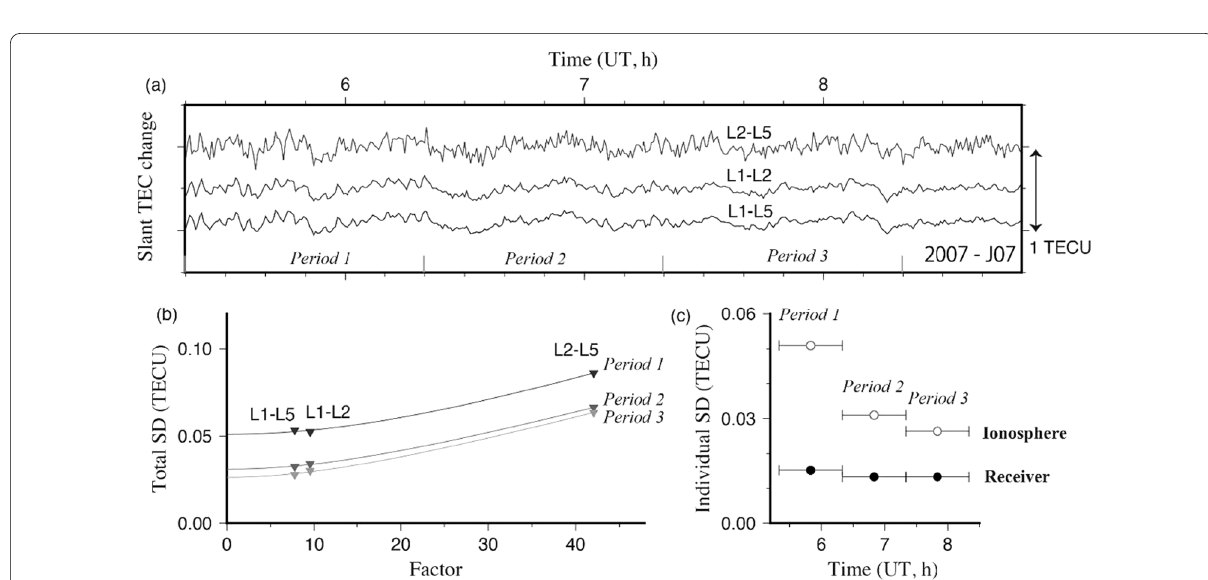
Fig. 7 a High-pass filtered slant TEC time series5:20–8:50 at the 2007 station observed using J07 satellite calculated with three different combinations of L1, L2, and L5 carrier phases. b Standard deviations of slant TEC σ tot obtained by the three combinations as a function of the frequency factor F in Eq. (1). Three curves correspond to Period 1 (5:20–6:20), Period 2 (6:20–7:20) and Period 3 (7:20–8:20). c Receiver noises σ rx remain nearly constant, while ionospheric scintillation σ ion decays rapidly with time. The receiver noise σ rx is scaled with the frequency factor for the L1–L2